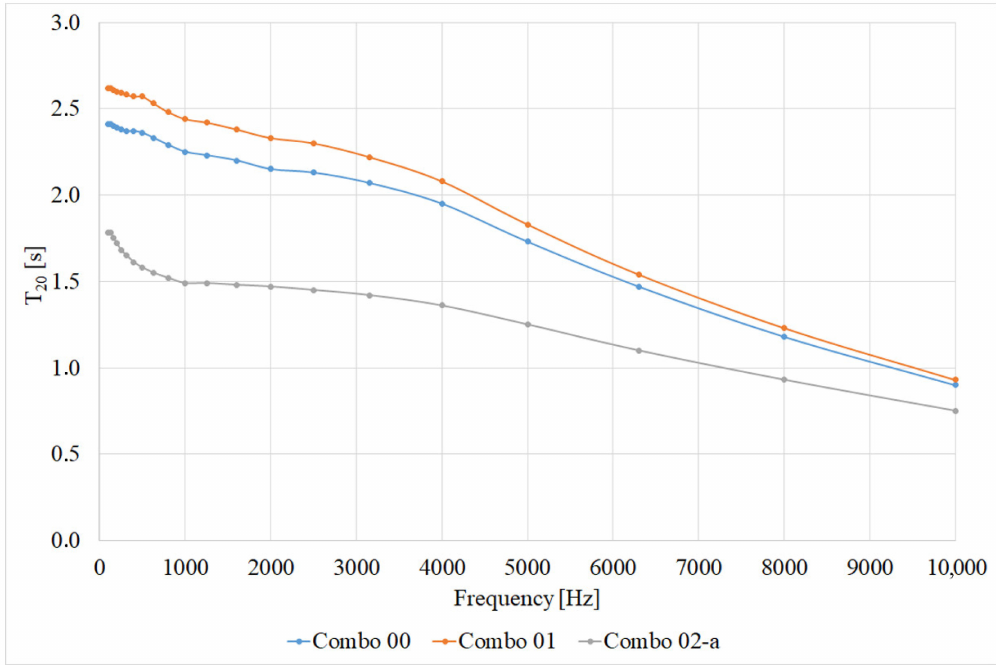
Figure 10. Reverberation time T 20 in the function of the frequency for each